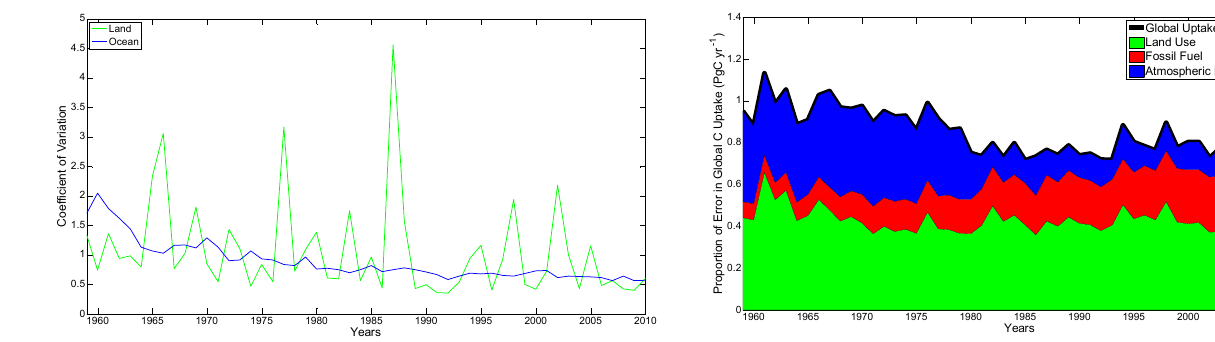
Figure 10. Coefficient of variation for net land and ocean C up- take for each year from 1959 to 2010. Coefficients of variation (CV) were calculated as the standard deviation/mean from each of our 4500 simulations of global annual C uptake. Values of CV for net land uptake (green) are compared with values of CV for net ocean uptake (blue). Absolute mean values were used to account for changes in sign of net land uptake that occurred over the 50-year pe- riod.